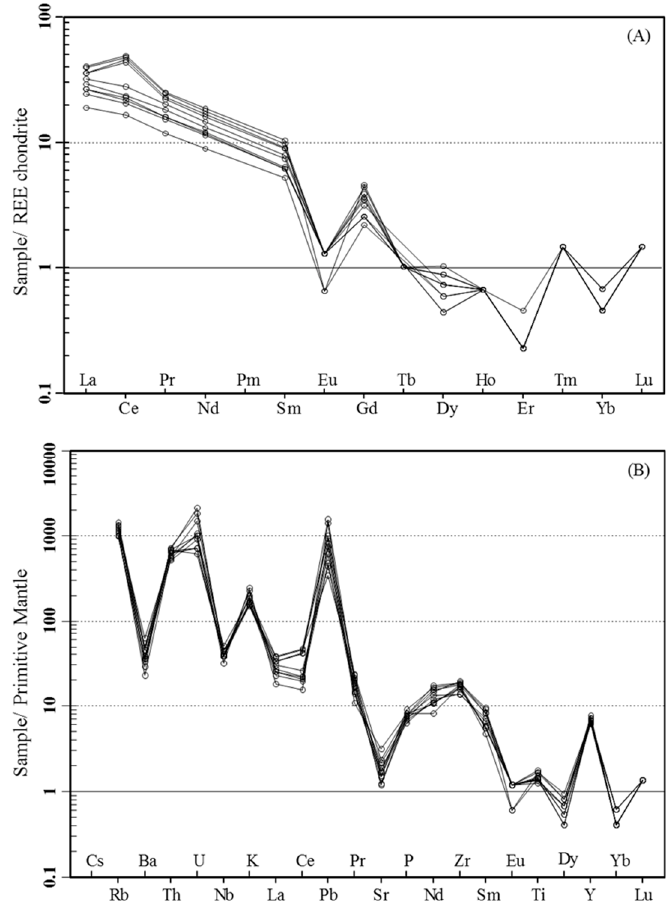
Figure 8. Chondrite normalized rare earth elements (REE) diagram ( A ) and primitive mantle normalized trace element diagram ( B ) for Tagu granitoids (normalizing values from [33]).